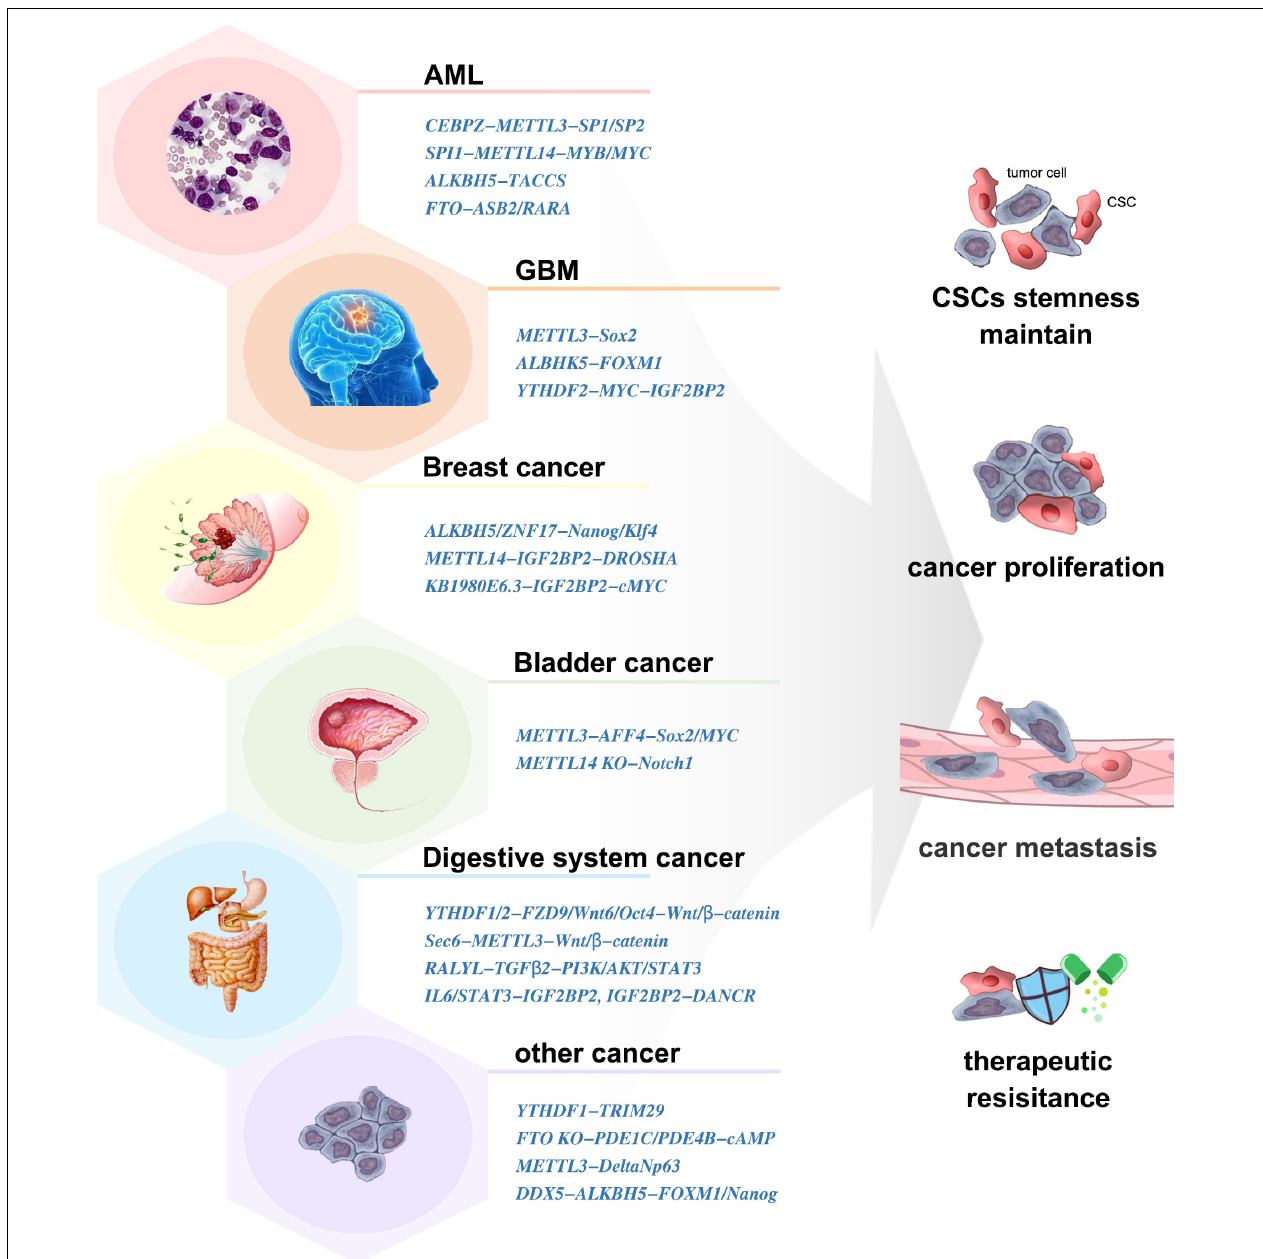
FIGURE 3 | The involvement of m 6 A in various cancer stem cells